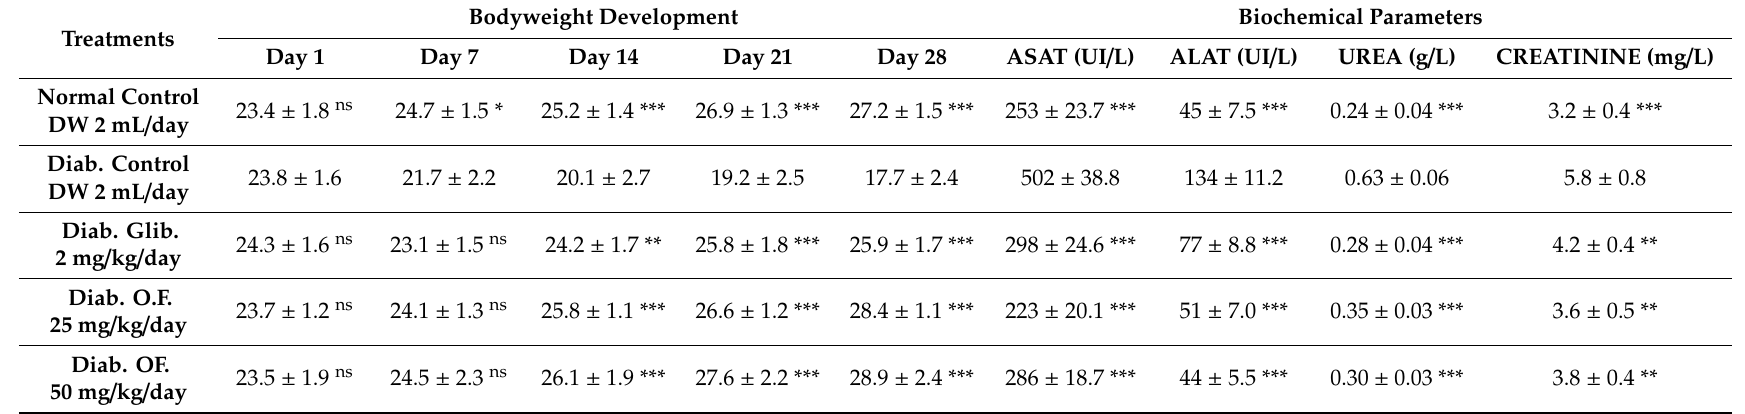
Table 2. E ff ect of flavonoids from oleaster leaves on bodyweight development and biochemical parameters of Alloxan-induced diabetic mice during the experimental period of 28